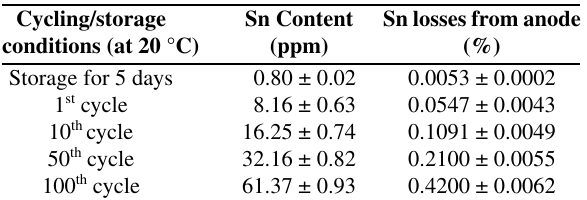
Table 3. Sn content by metal dissolution in the electrolyte (EC:DEC (3:7), 1M LiPF ) after cycling or storage of Sn-based 6 electrodes, detected by the TXRF method. Fe and Zn losses (%) are related to the sample weight. electrolyte solution: 100 μL; active material of Sn: 1.32 mg cm –2 , the error for the active material (Sn) is 0.02 mg cm –2 .